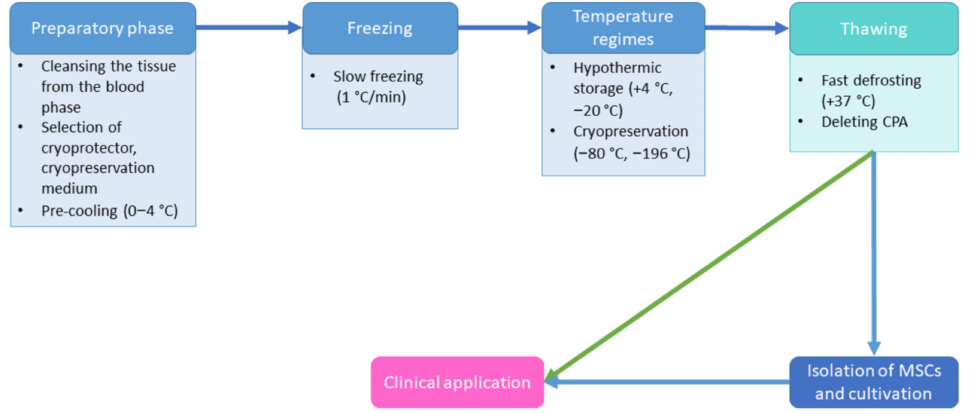
Figure 5. Generalized scheme of the protocol for cryopreservation of adipose